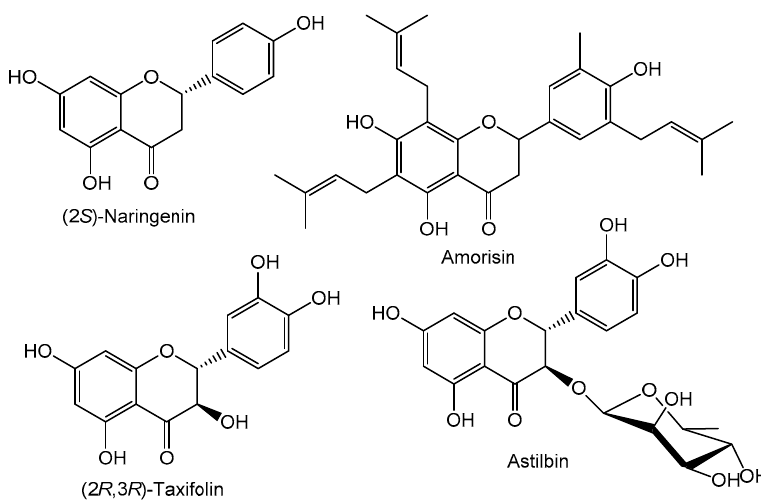
Figure 3. Examples of representative flavanones and dihydroflavonols.